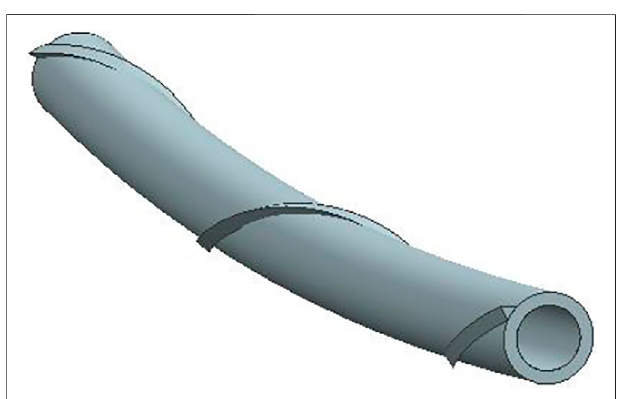
FIGURE 4 | The heat exchanger with triangular Turbolator in inner